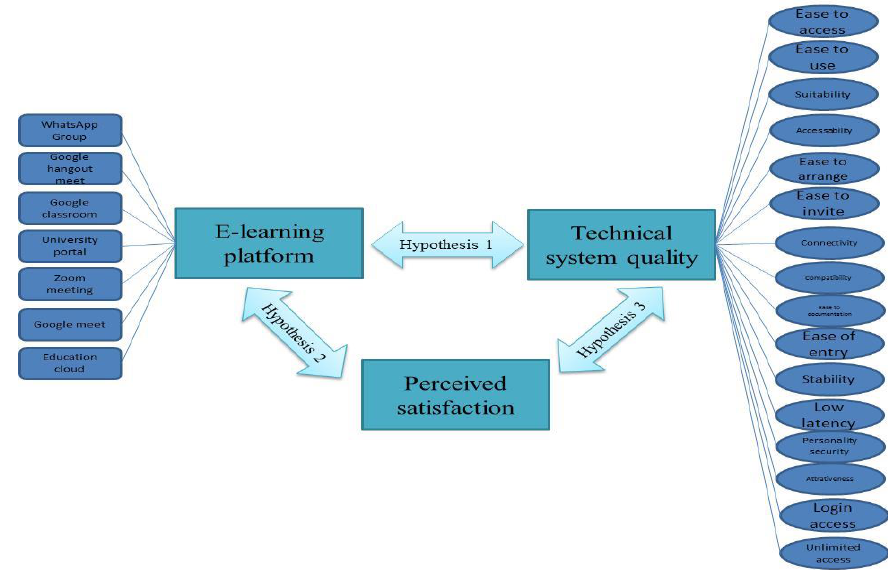
Figure 1. Conceptual